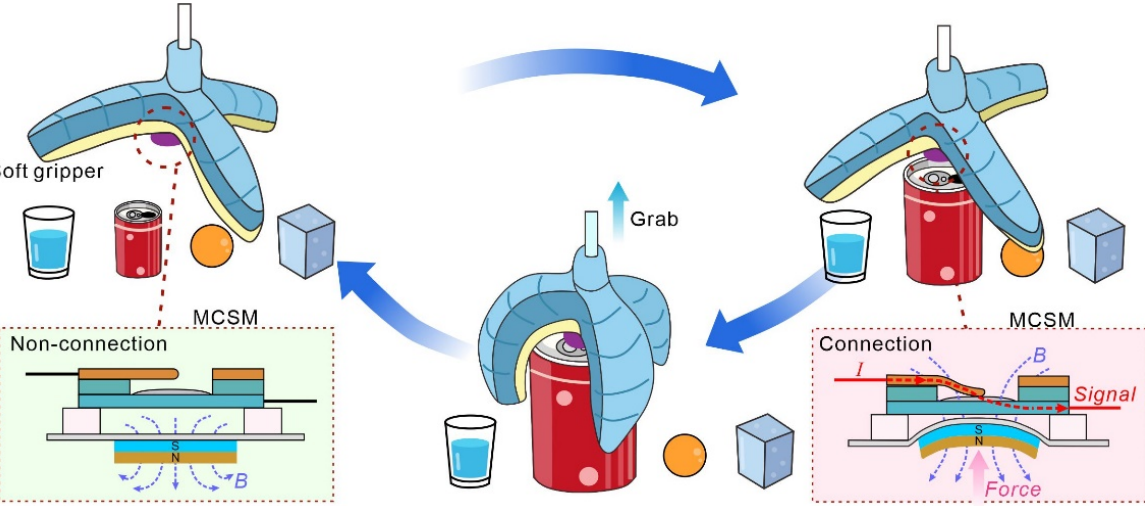
Figure 1. Schematic of a soft gripper integrated with an MCSM to self-sensing detect and grasp objects.